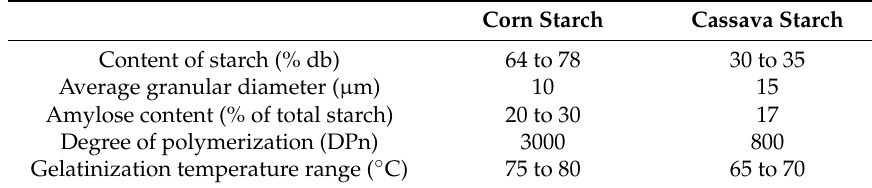
Figure 2. Schematics of the laboratory-scale conventional dry grind and GSH (granular starch hydrolysis) process for ethanol production. Table 1. Comparison of normal corn starch and cassava starch